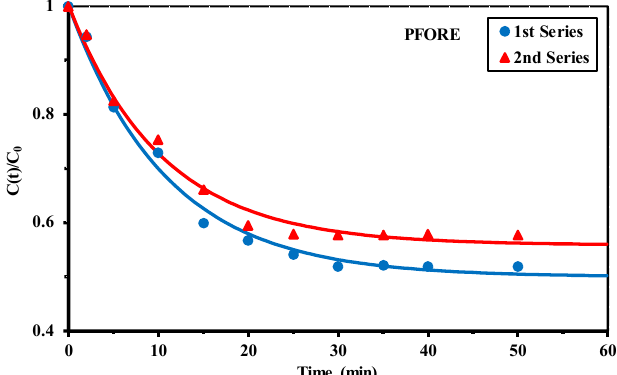
Figure 4. U(VI) uptake kinetics using Q-APEI sorbent—Modeling with the pseudo-first order rate equation (PFORE) (SD: 0.3 g L −1 ; pH 0 : 4; pH eq : 3.79–3.71; C 0 : 0.214 mmol U L −1 and 0.249 mmol U L −1